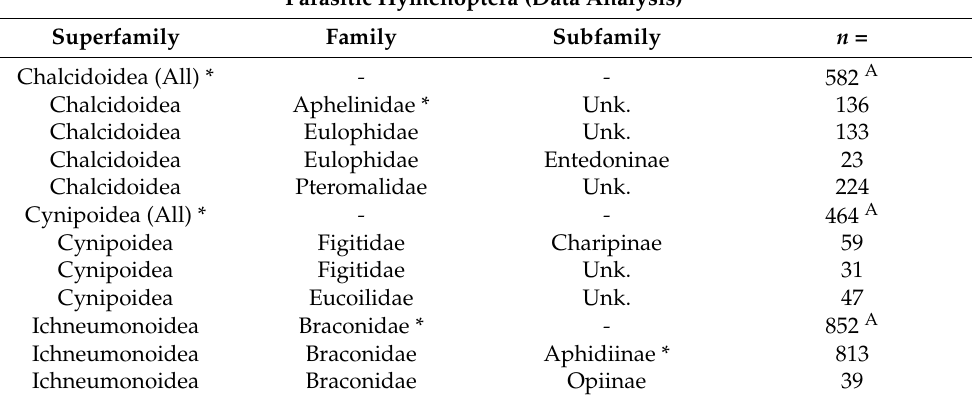
* = Included in final GLMM models. A = Total number of specimens per superfamily.